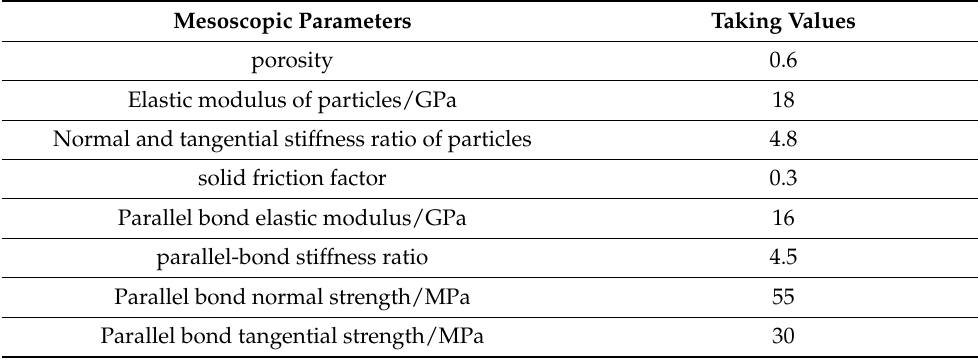
Figure 4. True triaxial modeling process. Table 2. Microscopic parameters of sample model particle